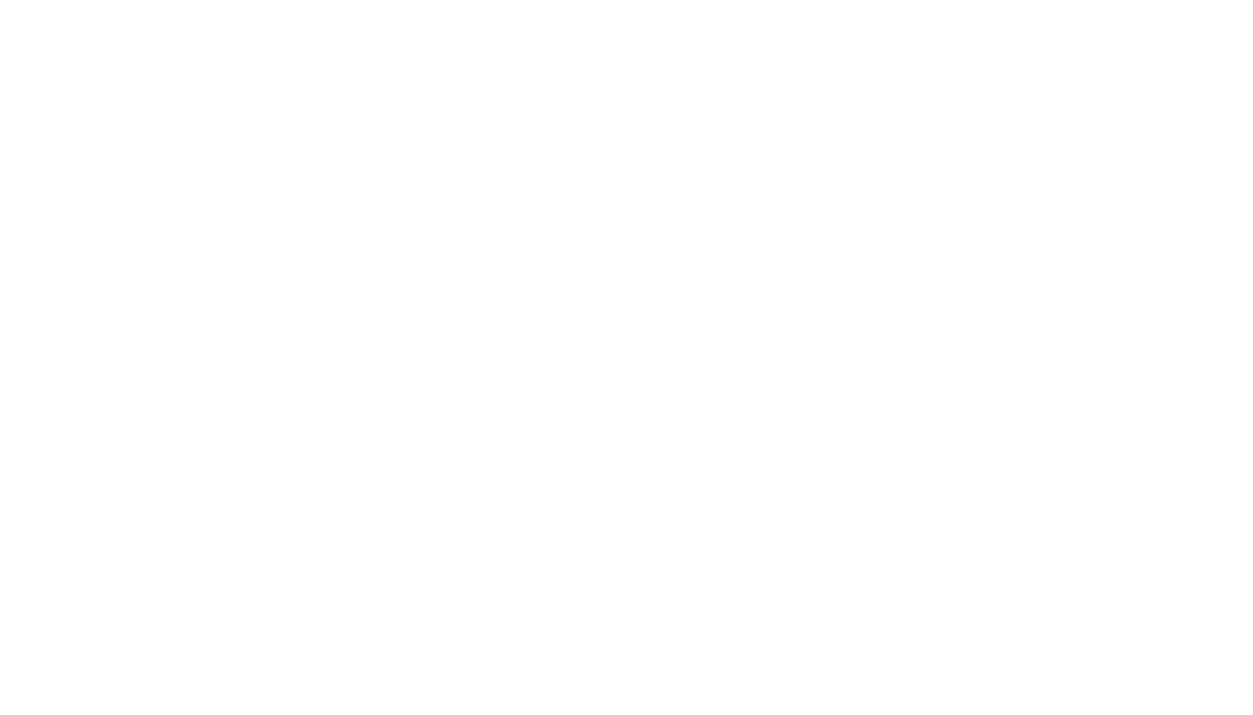
FIGURE 3 | Scatter plots showing core radius ( R c ) vs core mass ( M c ) for best-fit models with convective cores obtained using grid B (Run I). Top left is color-coded according to the model mass ( M ), top right is color-coded according to the initial metal mass fraction ( Z ), and bottom panel is color-coded according to the overshoot parameter ( f ov